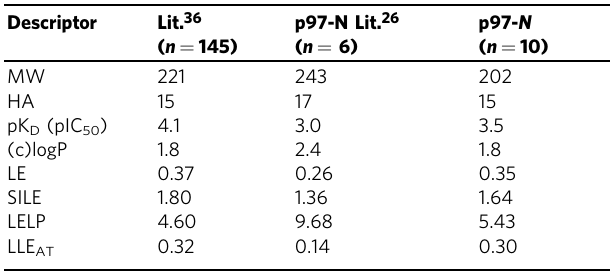
Table 2 Comparison of descriptor values and ligand ef fi ciency metrics for hits of fragment screens reported in the literature 36 , hits of the p97-N screen reported by Chimenti et al. 26 and the hits of this work as listed in Table 1. Mean